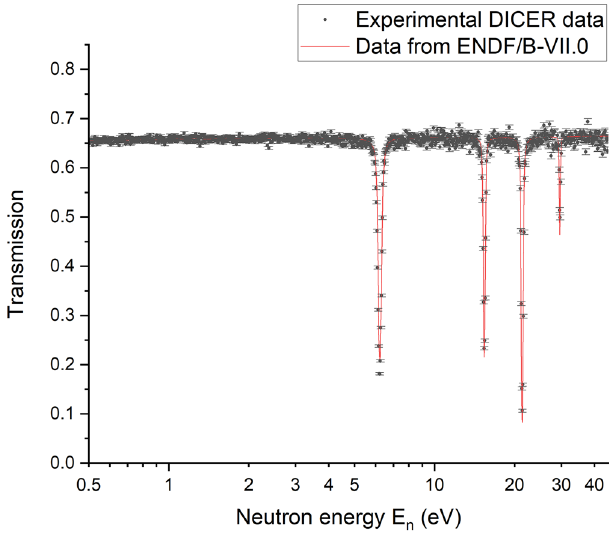
Figure 5. Measured DICER and ENDF neutron transmission through DCl/D 2 O nat Zr target: 8 µL of 2 mol·L −1